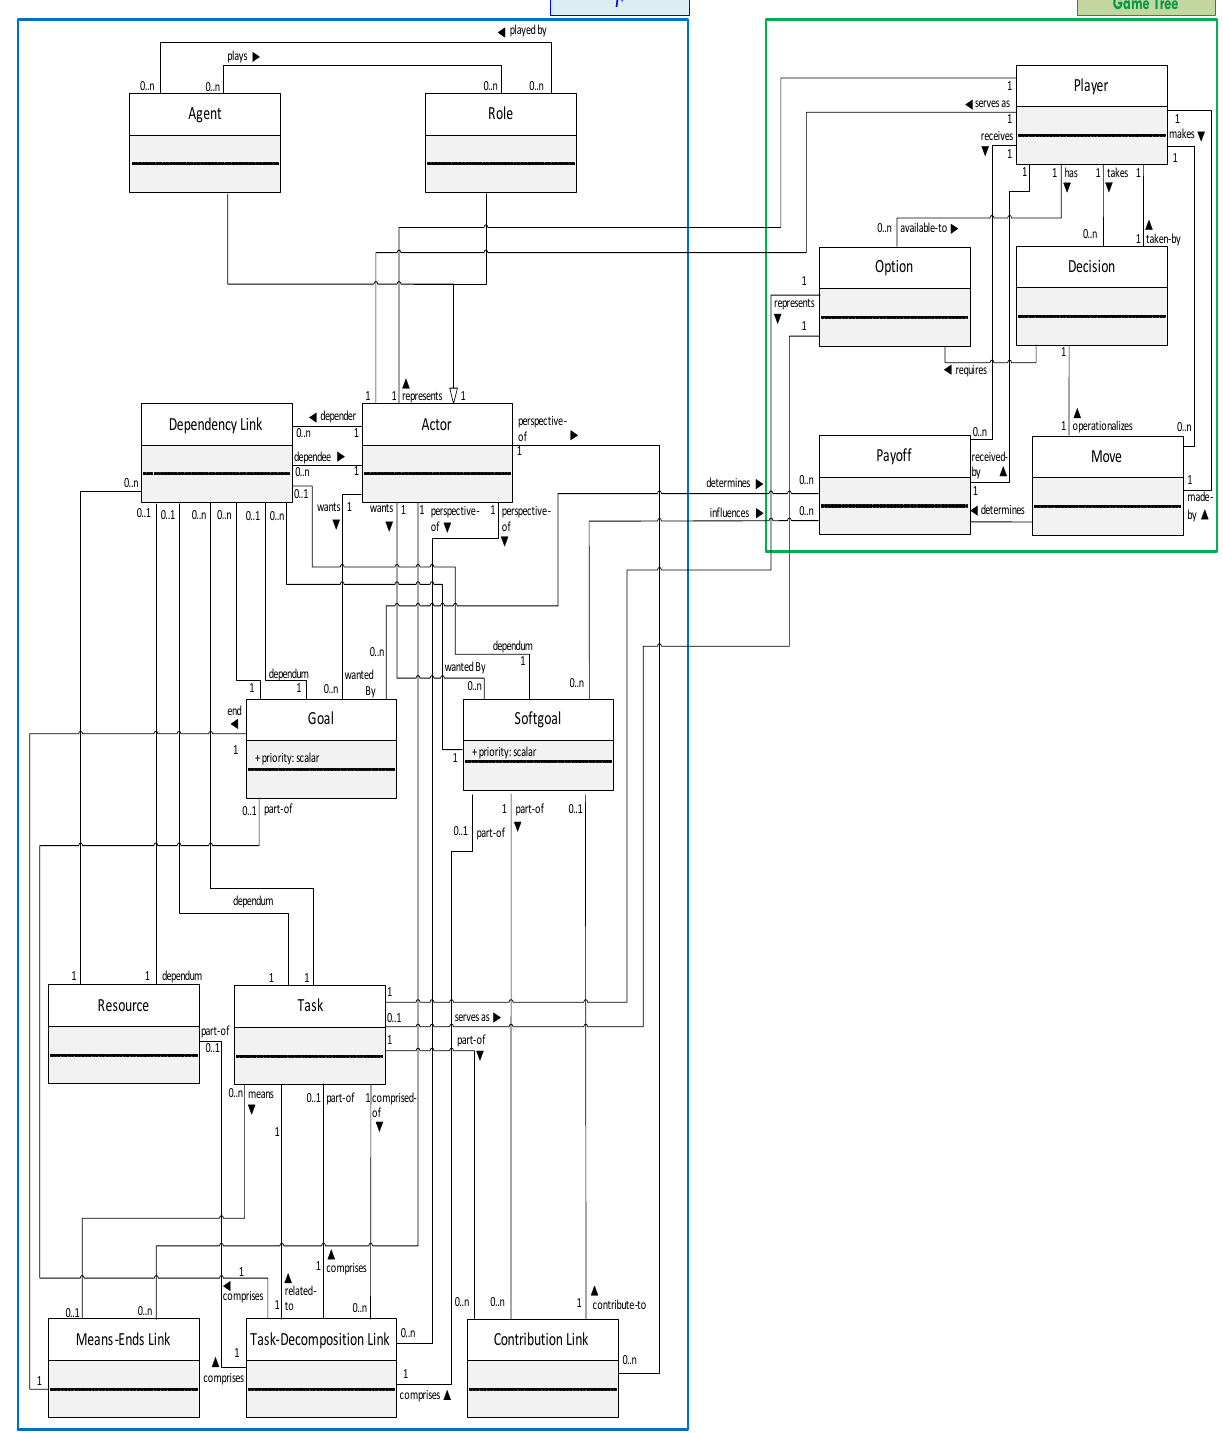
Figure 2. Metamodel for relating i* and Game Tree